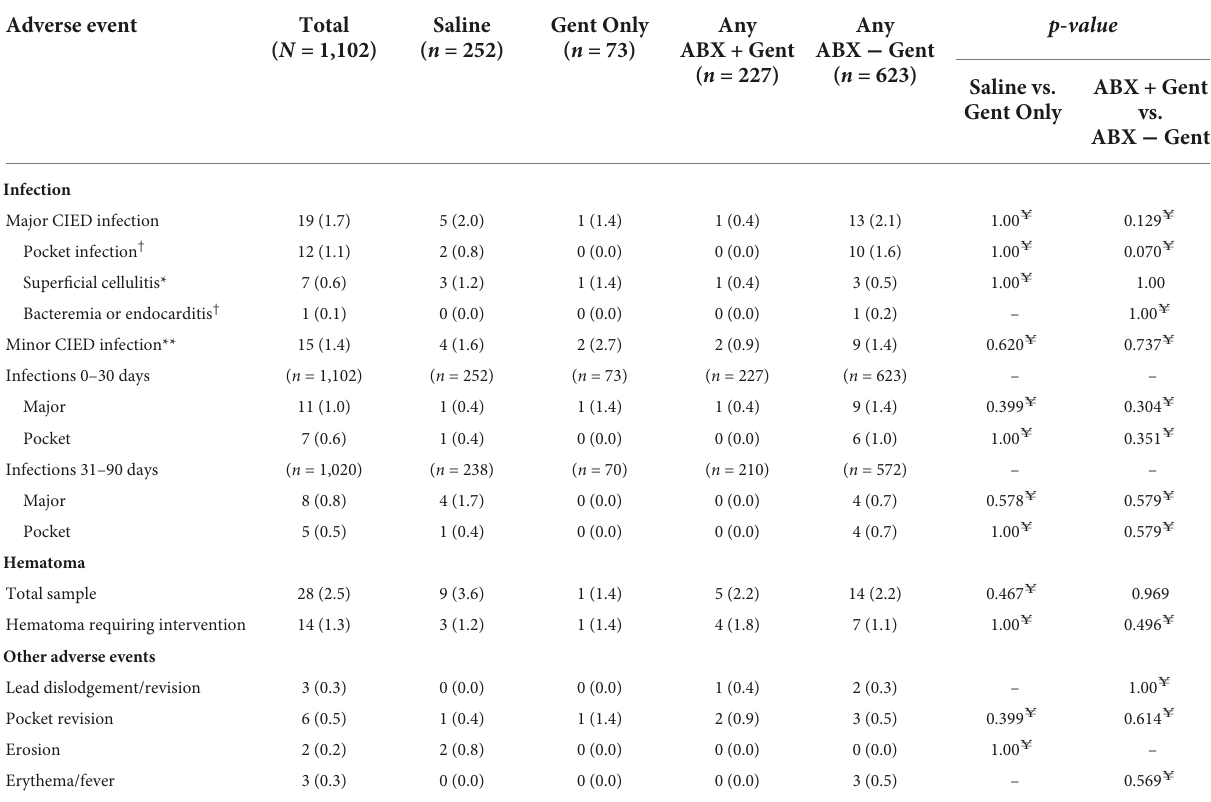
TABLE 4 Adverse